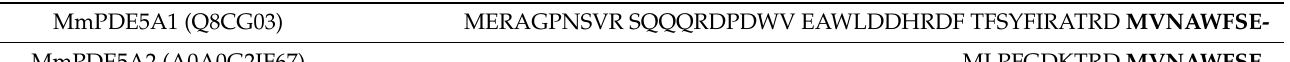
Table 1. N-terminal amino acid sequences (1 letter code) of MmPDE5 isoforms. The bolded section is the start of the common sequence, and the UniProt ID is in parentheses (https://www.uniprot.org (accessed on 23 March